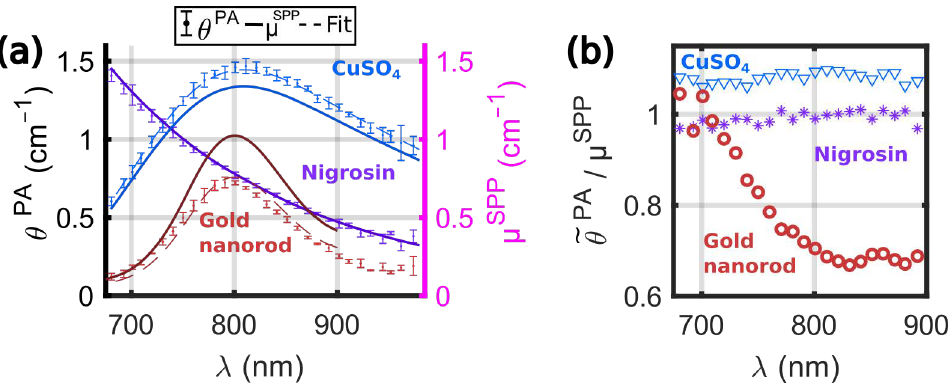
Figure 8. Experimental spectrum from a solution of gold nanorods (GNR). ( a ) PA coefficient θ PA ( λ ) of the GNR solution (red curves), the 20% solutions of CuSO4 (blue curves), and the 20% solutions of nigrosin (purple curves) were measured once in four tubes. The median ± MAD values of θ PA ( λ ) were displayed with dot markers and error bars. The attenuation coefficient µ SPP ( λ ) is displayed with a solid line. For the GNR, the attenuation coefficient was only available in the range 680 nm–900 nm. The fits of µ SPP to (cid:101) θ PA are shown with a dashed line of the same color as for θ PA ( λ ). ( b ) Ratios (cid:101) θ PA / µ SPP for the different solutions as a function of the optical wavelength. The same colors as for θ PA ( λ ) were